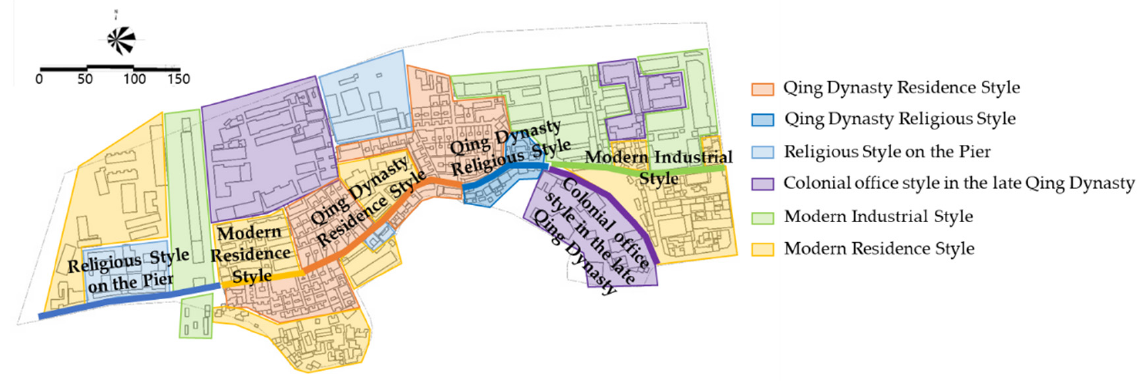
Figure 8. The “target historical style” diagram of Xijindu area.